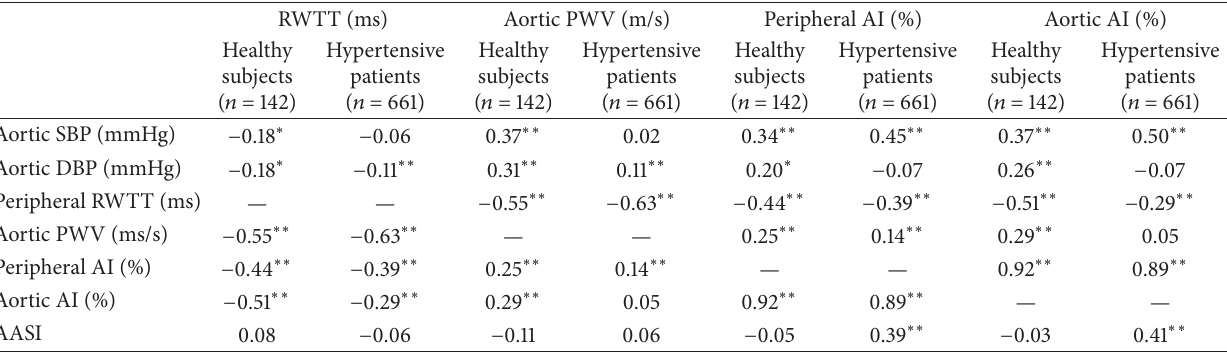
Table 4: Correlation coefficients between reflected wave transit time (RWTT), pulse wave velocity (PWV), augmentation index